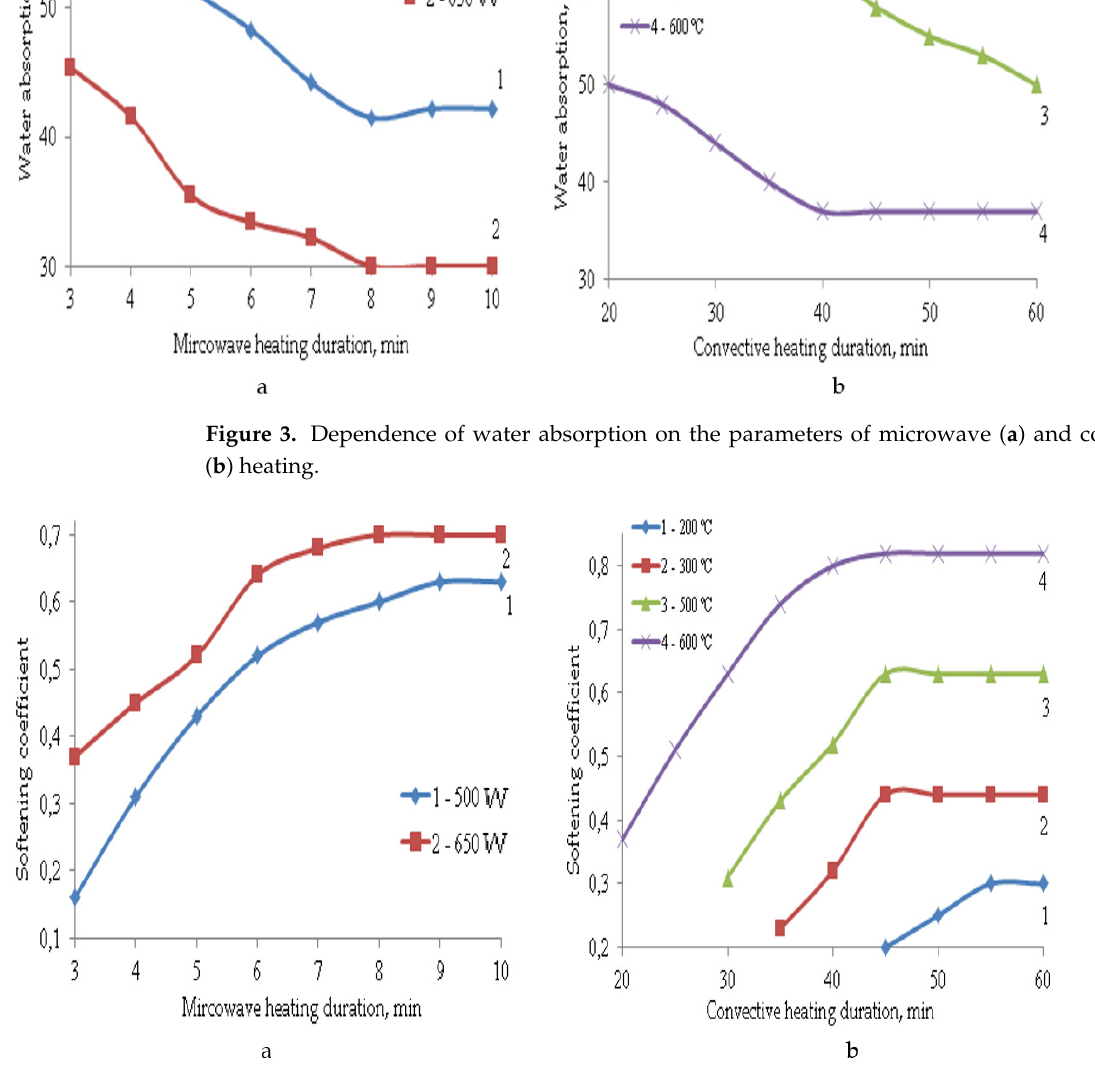
Figure 4. Dependence of the softening coefficient on the parameters of microwave ( a ) and convective ( b ) heating.